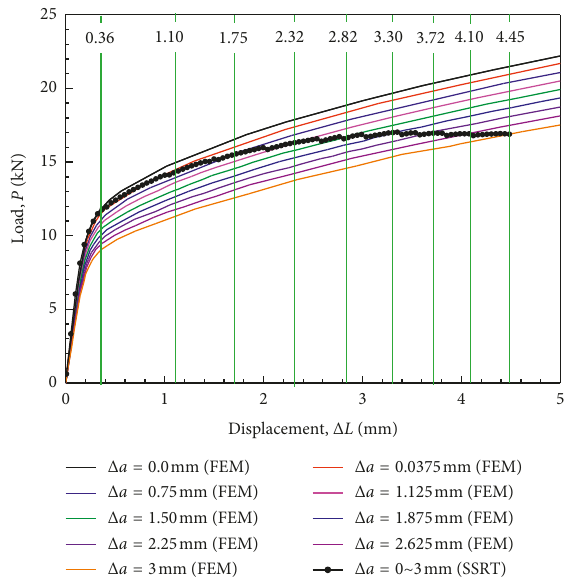
Figure 6: The integration of the numerical simulation and